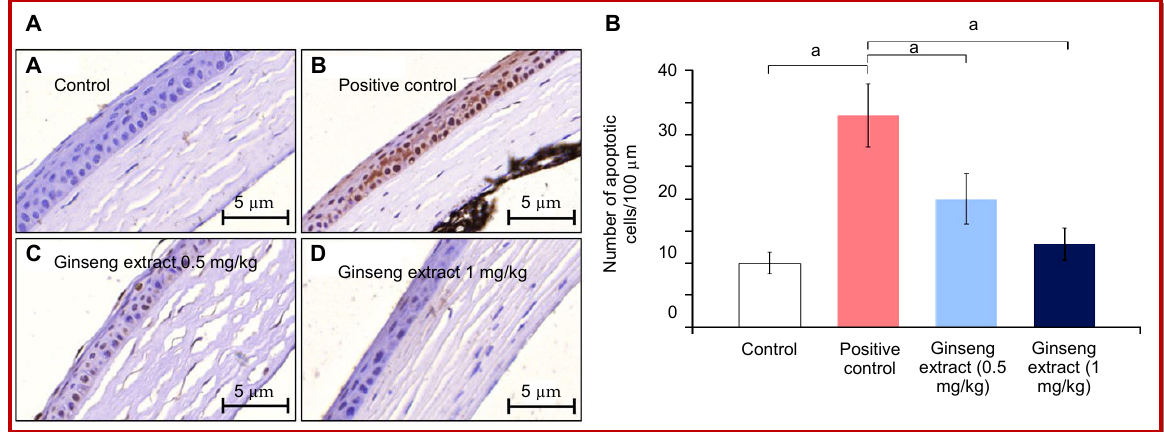
Figure 4: Evaluation of apoptosis via TUNEL assay on corneal sections. (A) Representative TUNEL staining images of corneal epithelial cells. (B) The number of apoptotic (TUNEL-positive) cells per 100 μ m tissue. Results are expressed as means ± SD for 4 mice per group. (n = 4, a p<0.01)